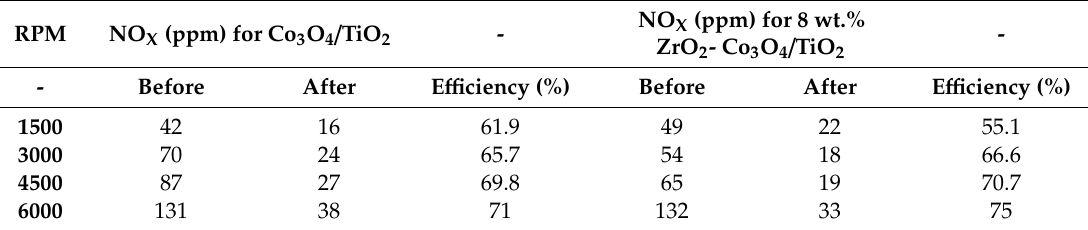
Table 1. Real time conversion results of NO X with both catalysts.